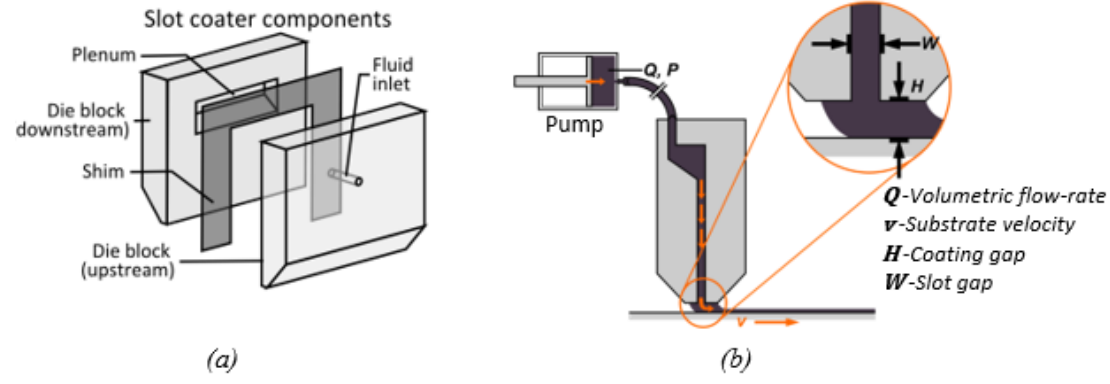
Figure 13. The slot die coating process: ( a ) the slot die head structure; ( b ) the schematic of slot die coating process.